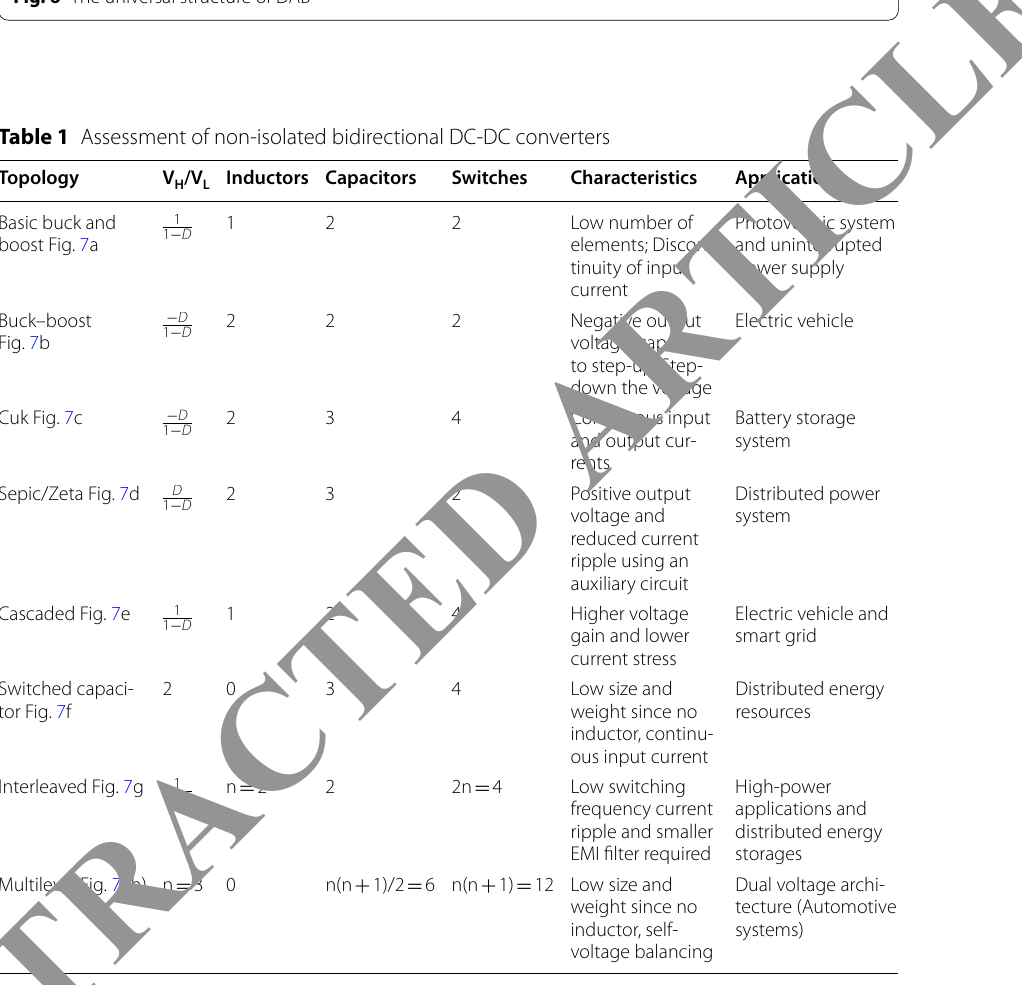
Multilevel Fig. 7 (h) n